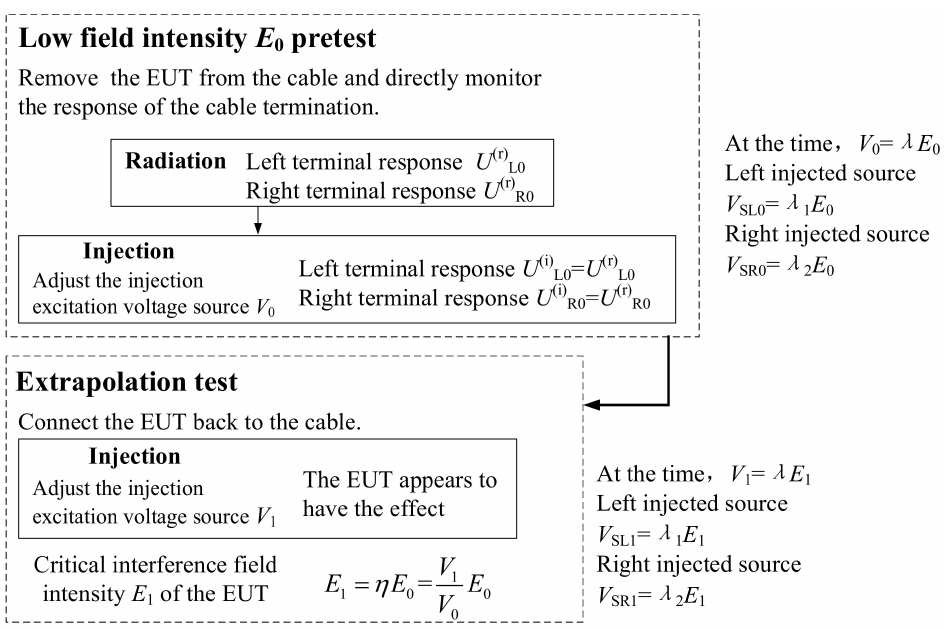
Figure 5. Test method of substituting DBCI for high-field-intensity electromagnetic radiation.